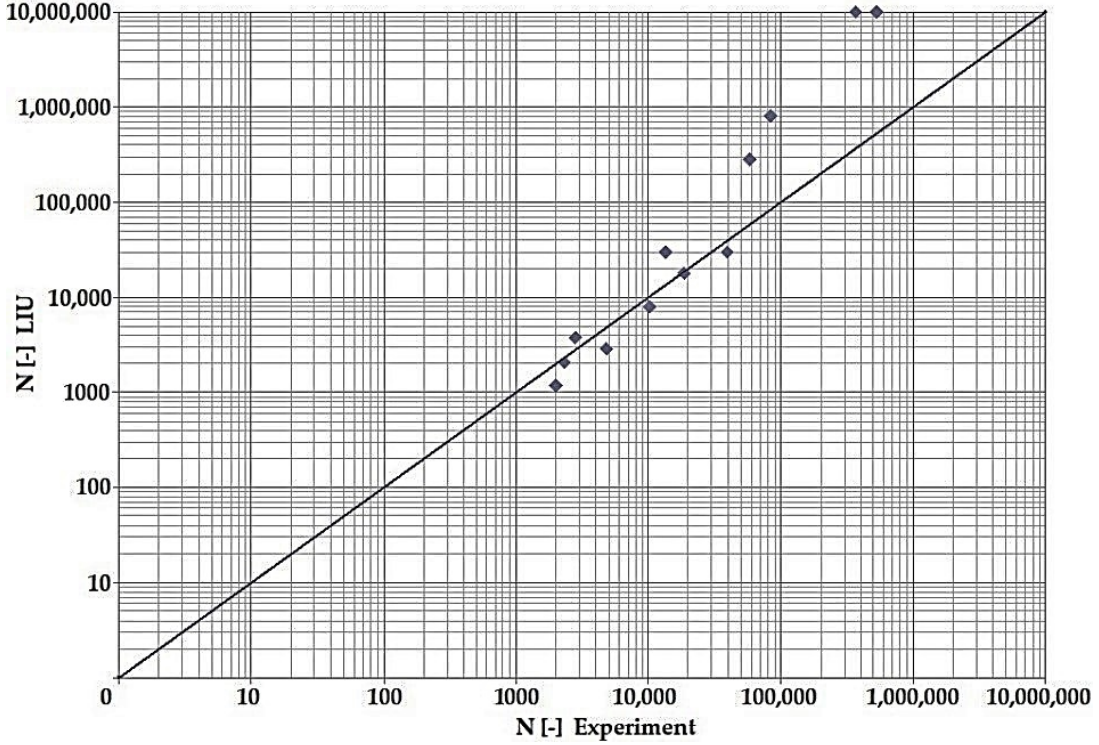
Figure 28. Dependence of theoretical and experimentally obtained number of cycles, Liu vs. experiment, phase shift 90°.